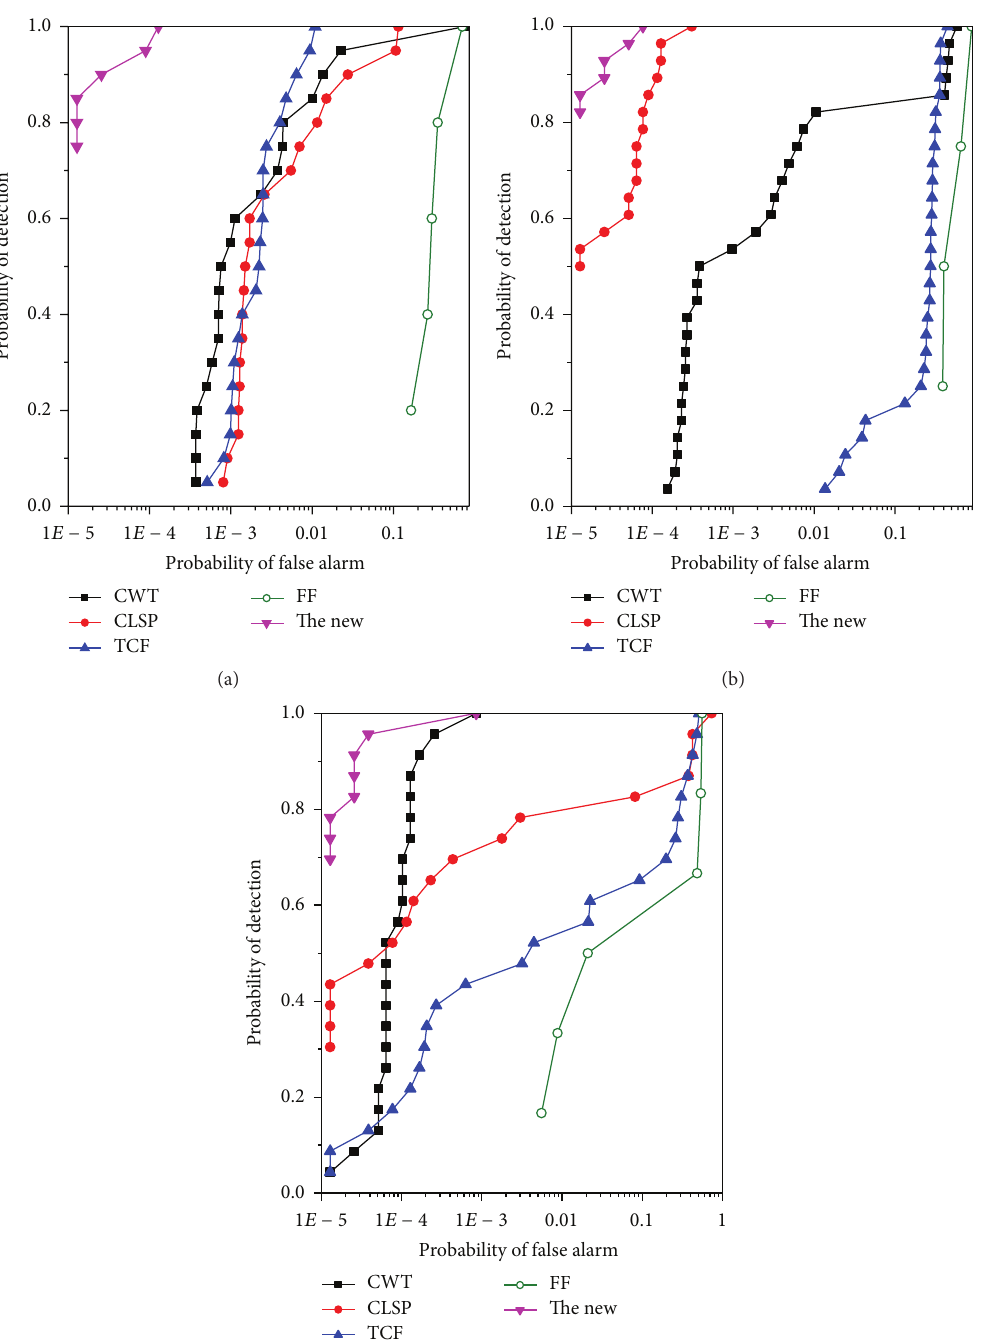
Figure 11: ROC curves. (a) ROC curves of “npa” scene. (b) ROC curves of “j2a” scene. (c) ROC curves of “na23a”